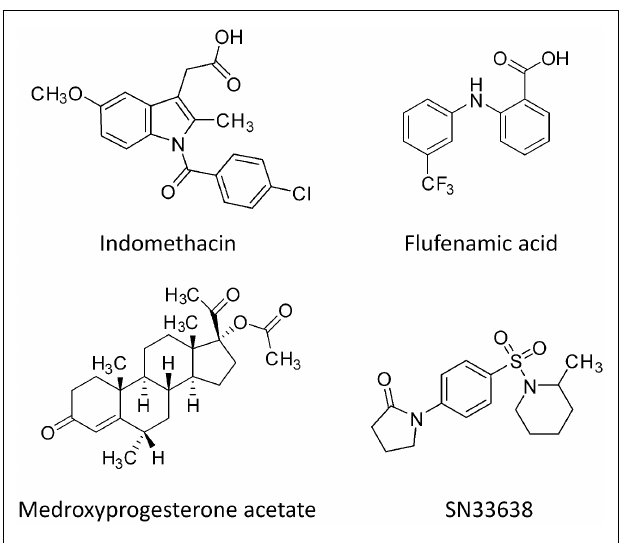
FIGURE 1 | Chemical structures ofAKR1C3 inhibitors